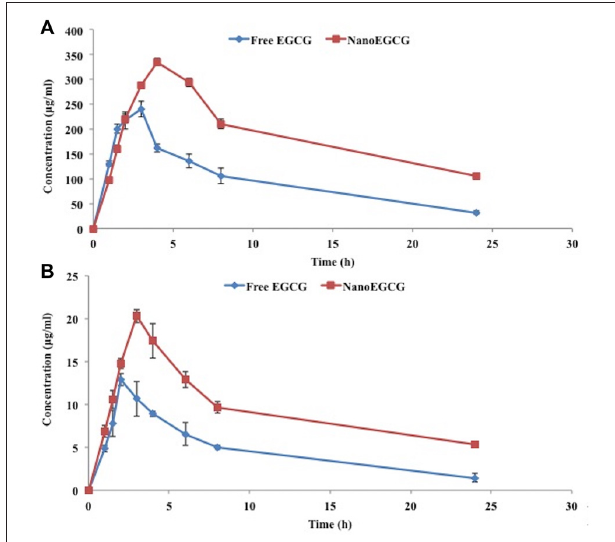
FIGURE 8 | (A) Plasma and (B) brain concentration of unconjugated EGCG after the oral administration of free EGCG and